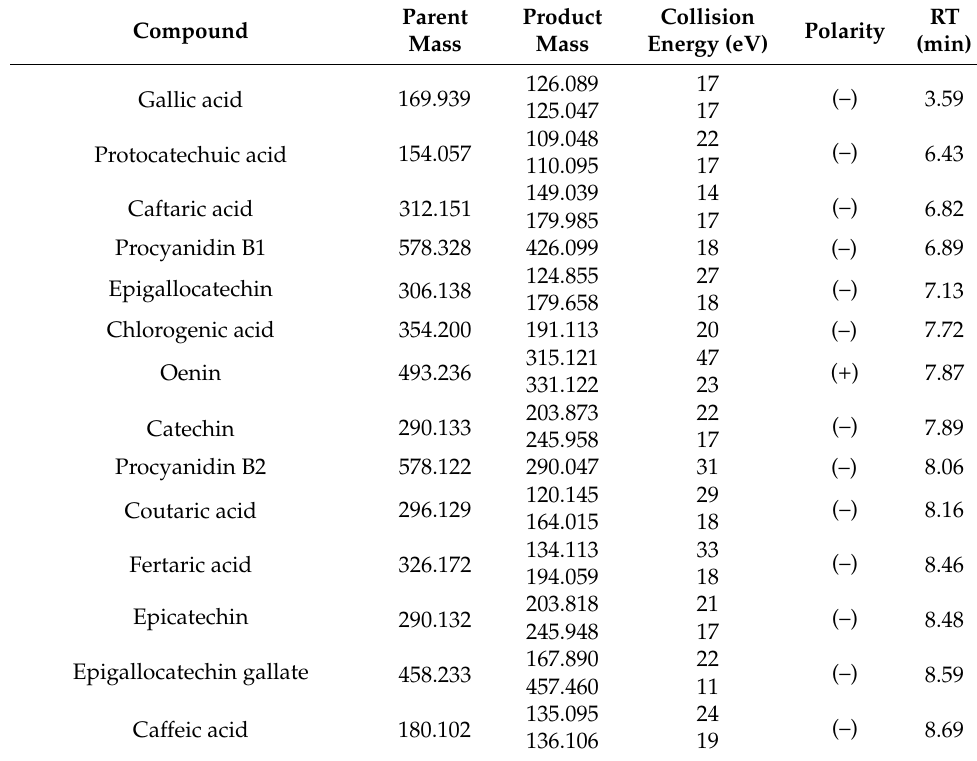
Table 1. Transition, collision energy, polarity and retention time (RT) applied for each phenolic standard.